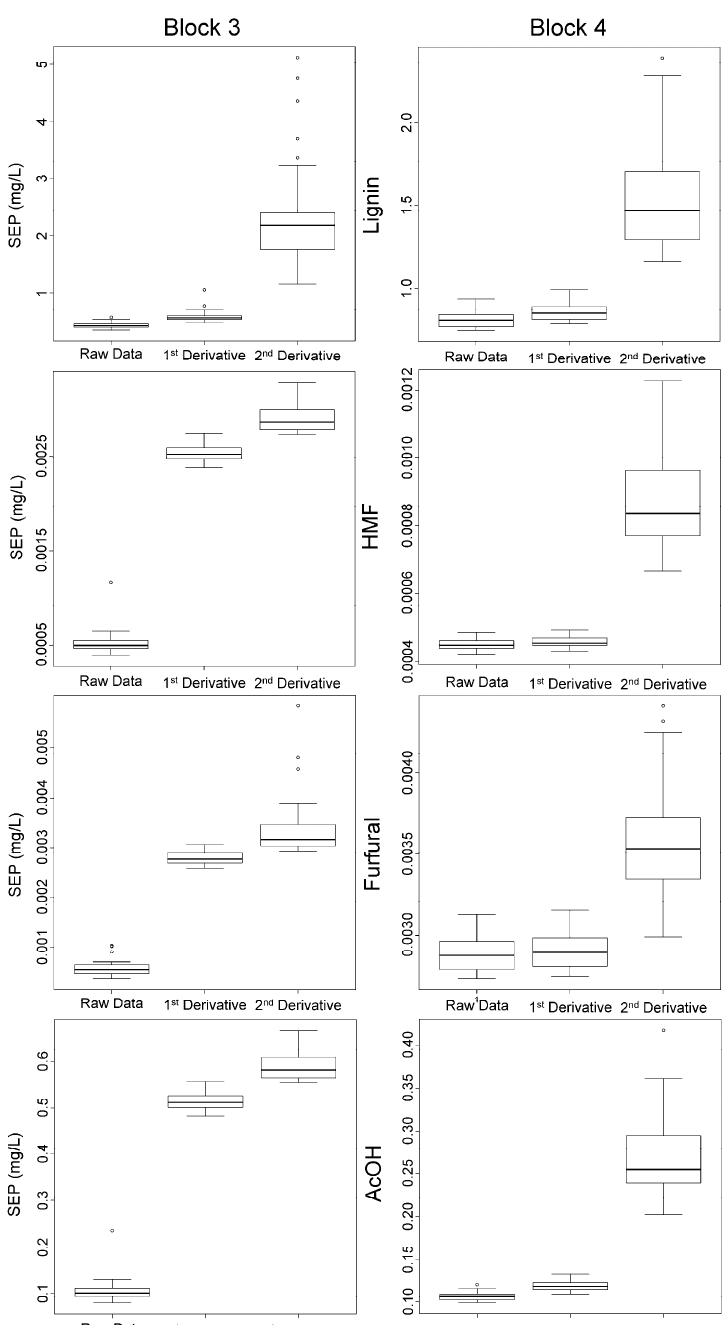
Figure 3. Box plots of SEPs obtained by rdCV (50 repetitions) for the raw data and the first and second derivative for all components using data block 3 and 4.